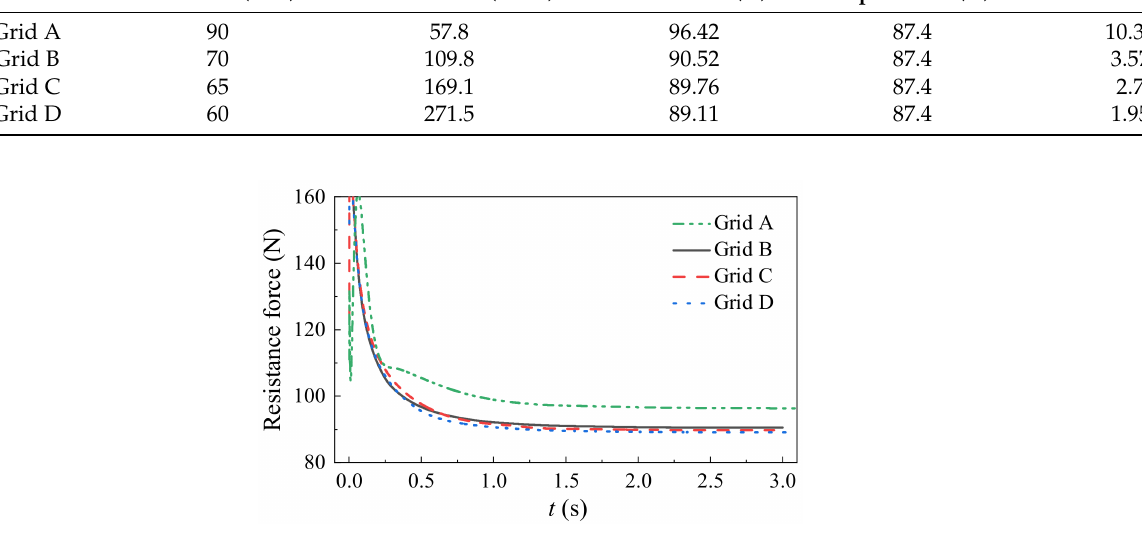
Figure 3. Time series of resistance force.